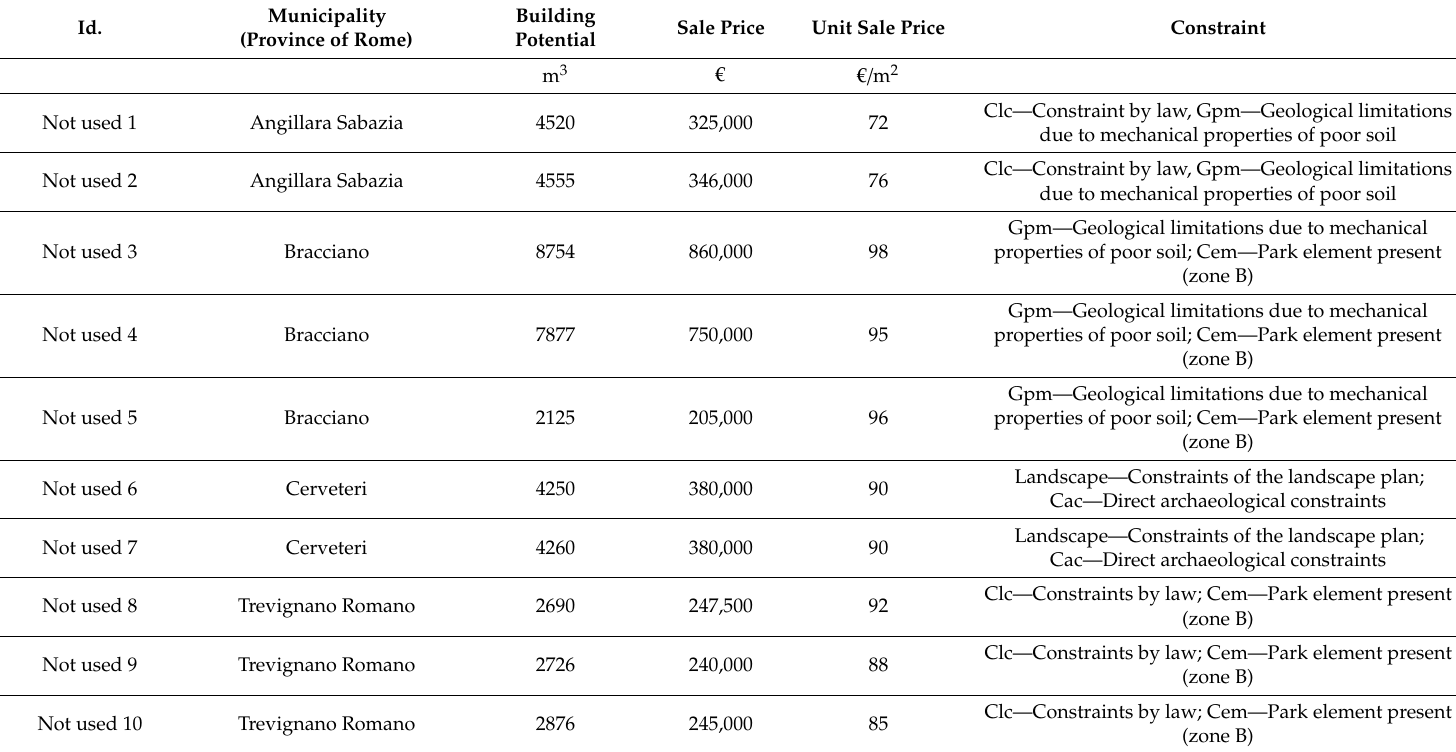
Table 3. Sample of data collection found but not